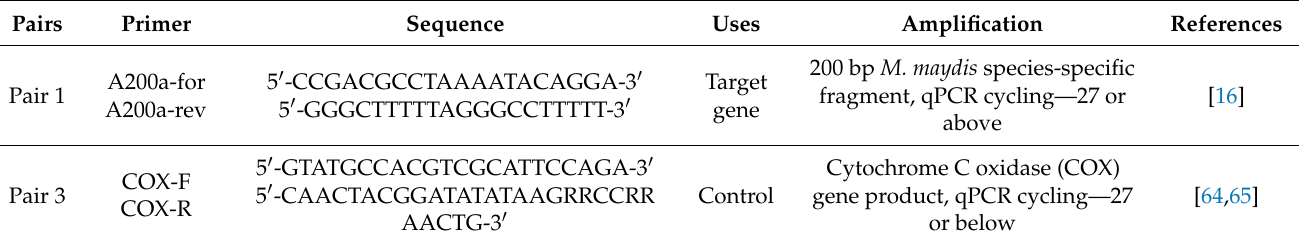
Table 4. Primers for Magnaporthiopsis maydis detection 1